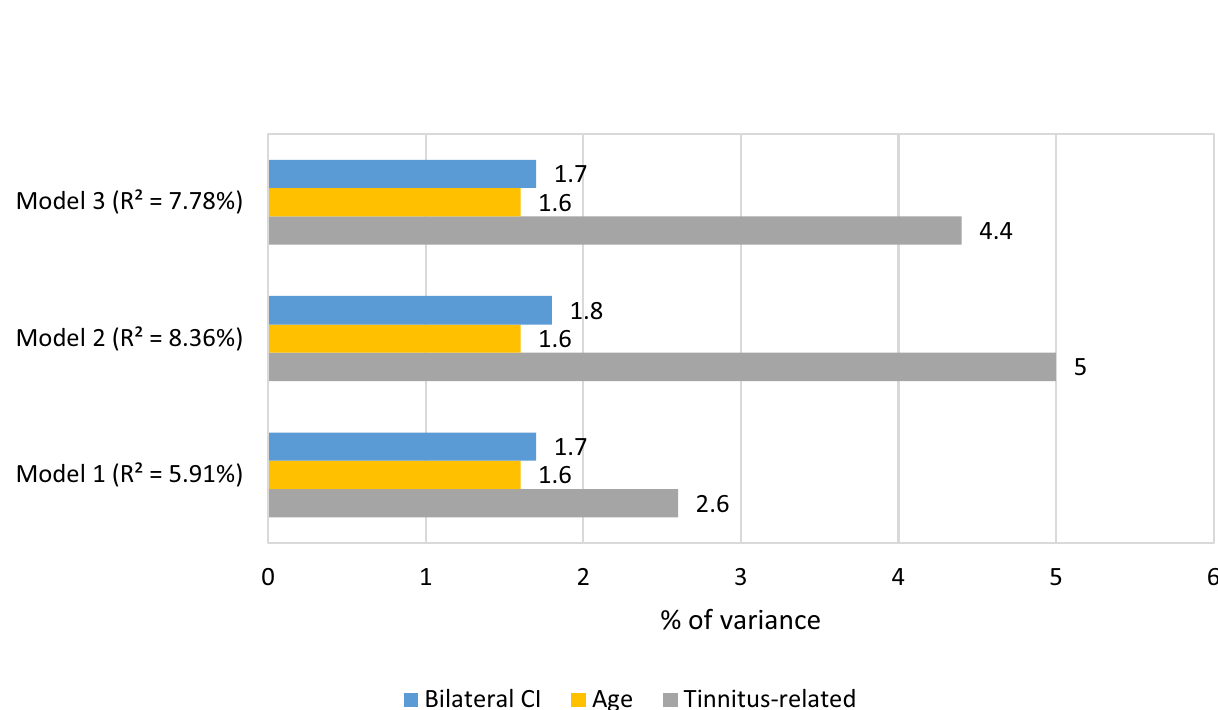
Figure 4. Relative importance of predictors (% of variance) in Model 1, Model 2, Model 3. The method used for relative importance is the Lindeman, Merenda and Gold’s (LMG) method. R 2 corresponds to the determination coefficient of each